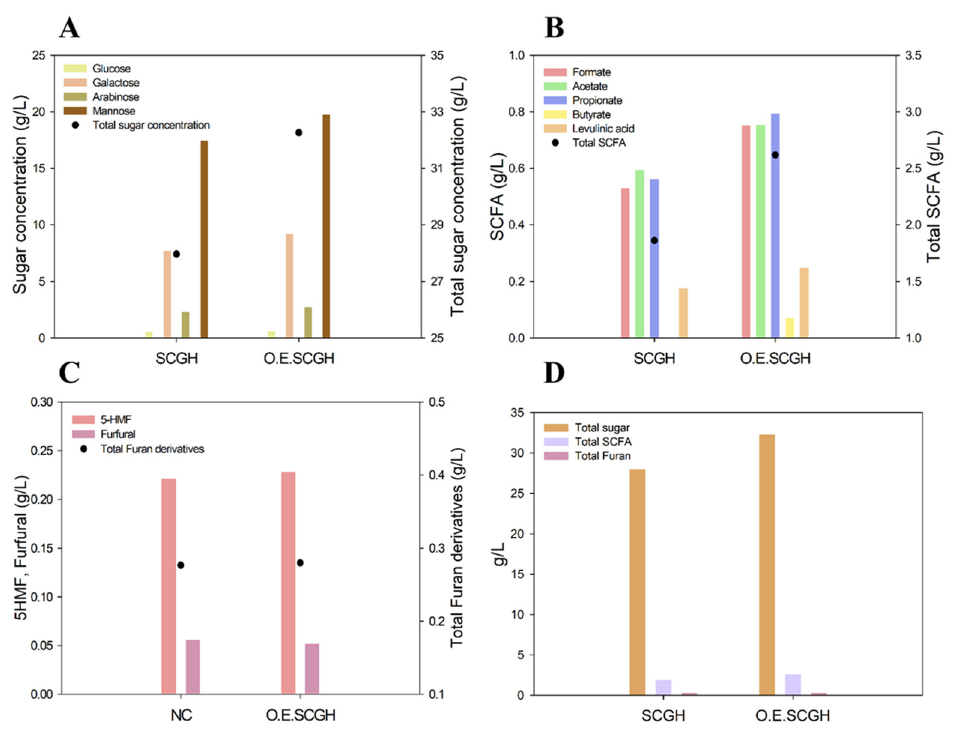
Figure 1. Comparison of spent coffee grounds hydrolysate (SCGH) and oil–extracted spent coffee grounds hydrolysate (OESCGH). ( A ) sugar composition; ( B ) SCFA composition; ( C ) furan derivatives composition; and ( D ) composition of sugar, SCFA and furan derivatives.